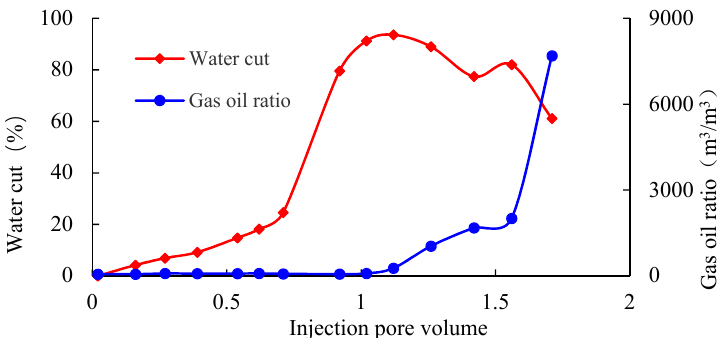
Figure 11. The relationship between injected pore volume and water cut, gas–oil ratio (0.45 mD core). (2) Oil displacement of 0.98 mD core